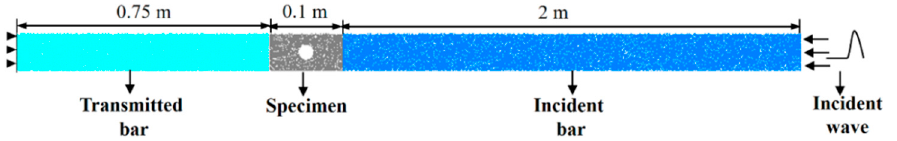
Figure 5. Schematic diagram of SHPB simulation model. Table 1. Micro-parameters of specimen after calibration.